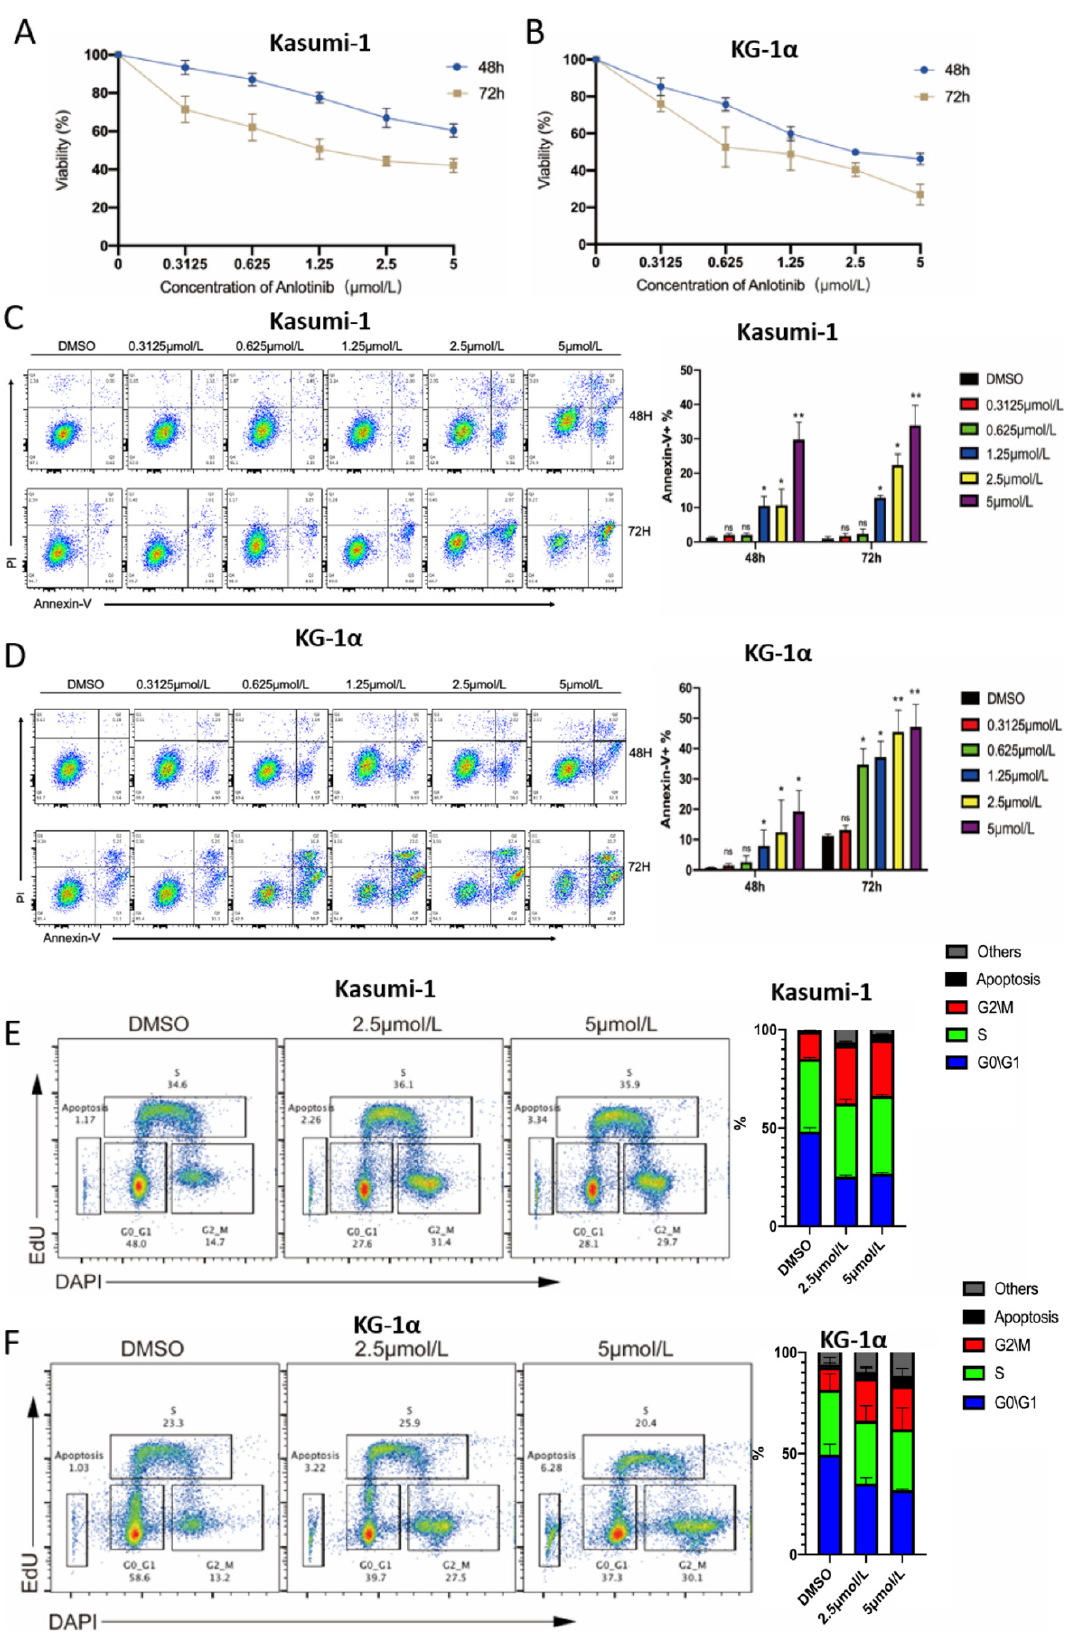
Figure 1. Anti-LSC activity of anlotinib in vitro. ( A , B ) Cell proliferation was detected by CCK-8 assay of CD34 + CD38 − Kasumi-1 cells ( A ) and KG-1 α cells ( B ) after treatment with the indicated